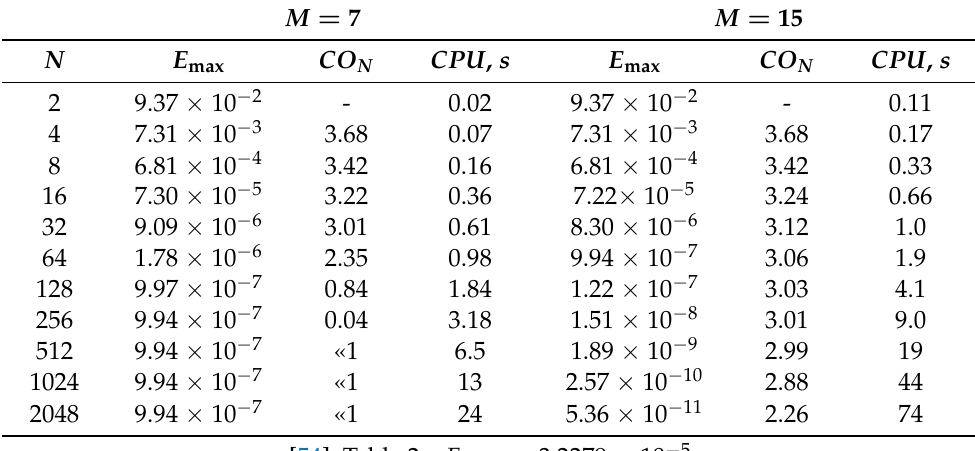
Table 2. The MAE, CO N , and the elapsed time versus the N using M = 7 (left) and M = 15 (right).